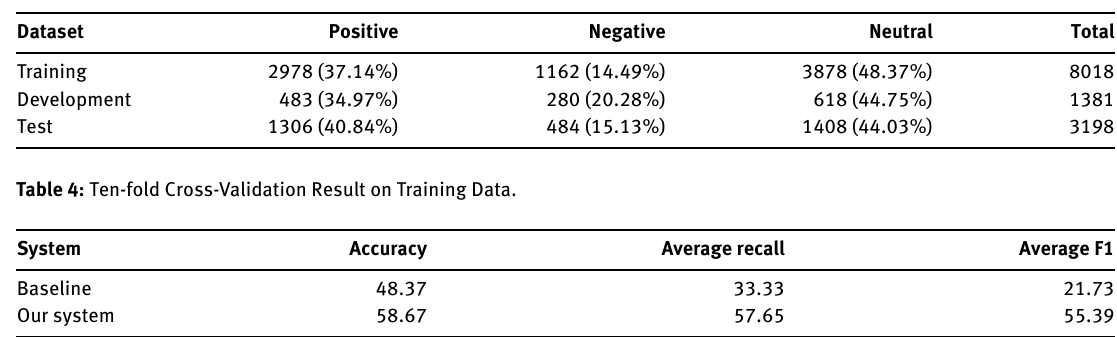
Table 3: SemEval-2013 Task 2 Data Statistics.